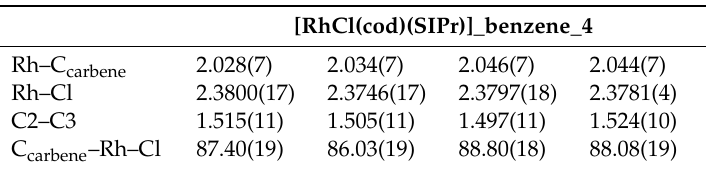
Table 3. The most important bond lengths (Å) angles ( ◦ ) of the four individual molecules in the unit cells of the benzene solvate of 4 , i.e., [RhCl(cod)(SIPr)]_benzene_ 4